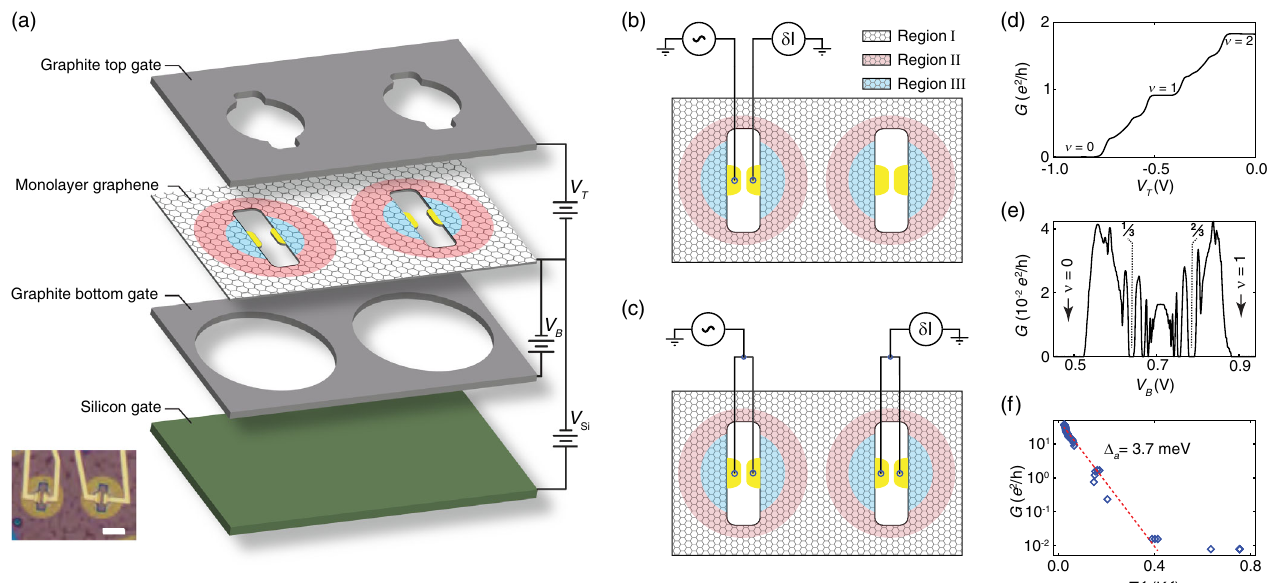
FIG. 1. Transport measurement on device A. (a) Schematic of the device geometry. Inset: optical micrograph of the sample. Scale bar represents 5 μ m. (b) Schematic of the intraisland transport measurement. (c) Schematic of the interisland transport measurement. 0 , and V 10 V. V (d) Intraisland conductance as a function of V measured at B ⊥ ¼ 8 T, V , V , and V are the voltage T B ¼ B T Si ¼ Si applied on the graphite top gate, the graphite bottom gate, and the silicon gate, respectively. (e) Interisland conductance as a function of − 0 . 3556 V, V 6 . 5 V. (f) Arrhenius plot of the conductance at the charge neutrality point; linear V measured at B ⊥ ¼ 8 T, V B T ¼ Si ¼ fitting of the data shows the sample is insulating with an energy gap of 3.7